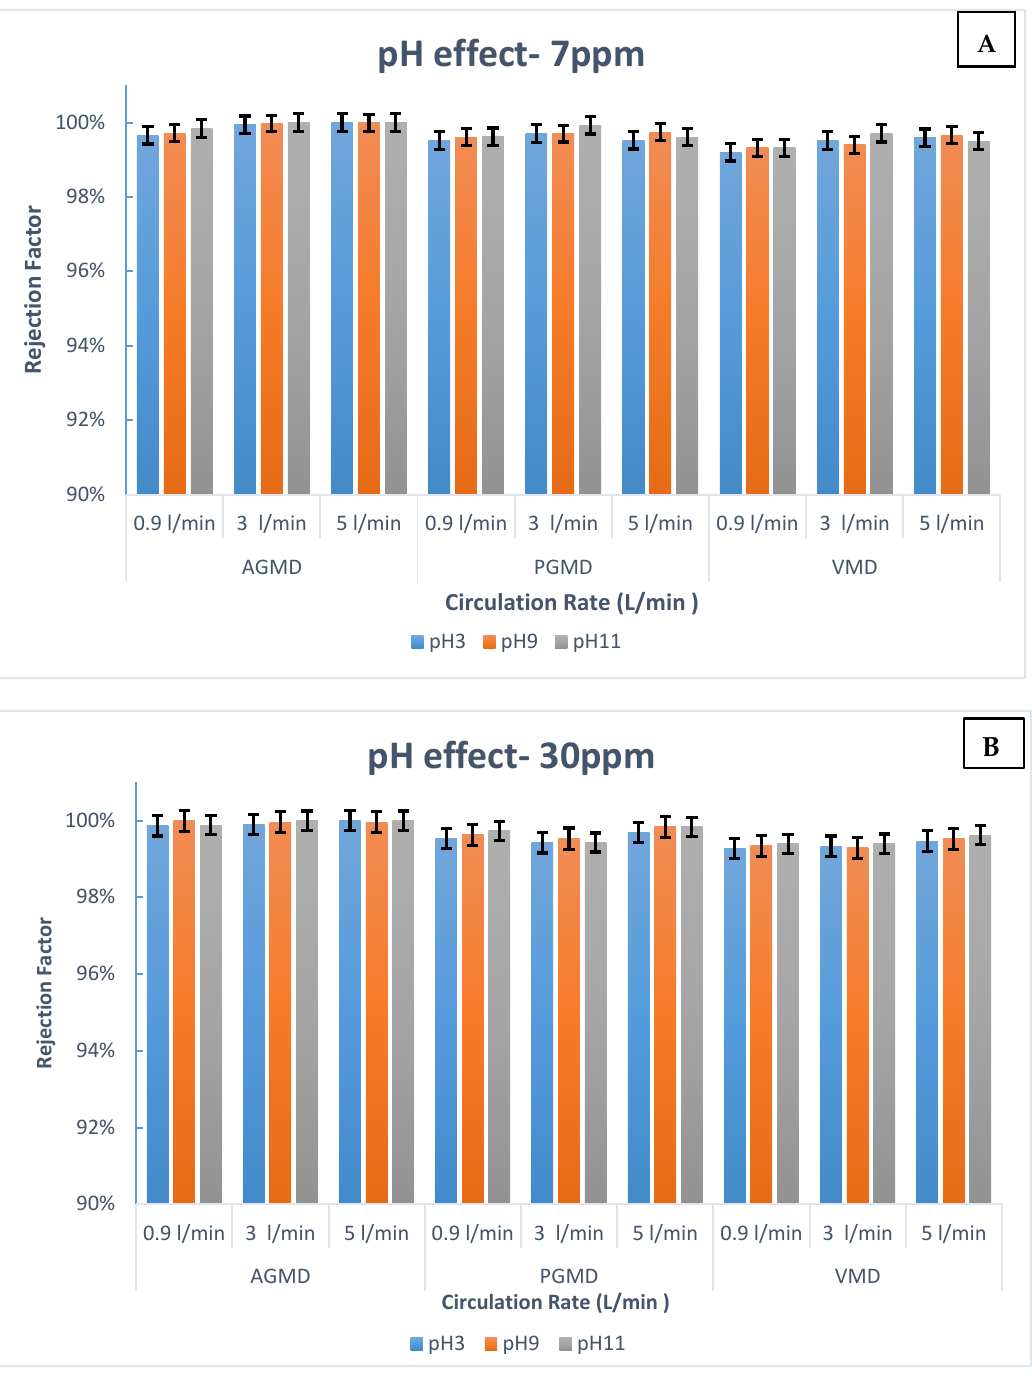
Figure 4. Influence of pH on boron retention at different feed circulation rates and initial boron concentrations: ( A ) 7 ppm and ( B ) 30 ppm for AGMD, PGMD, and VMD.